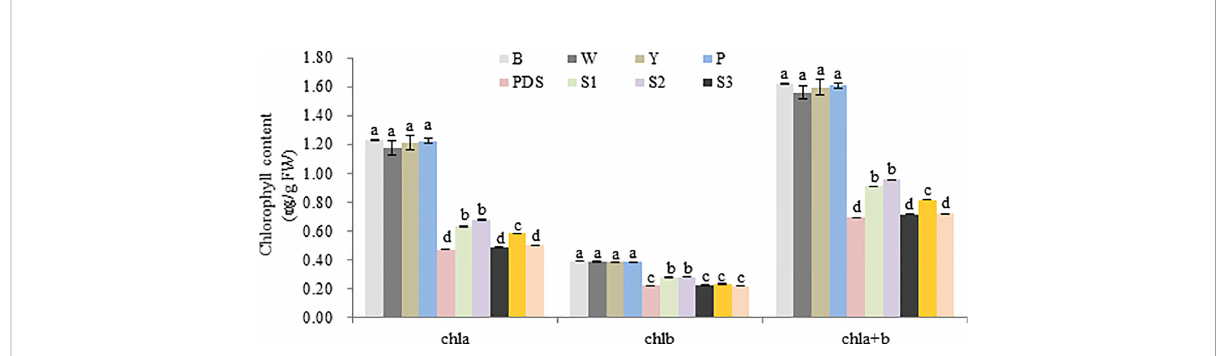
FIGURE 10 Chlorophyll content of different treatment group. B, W, Y, P, PDS, S1, S2, S3, S4,and S5 represents blank control, water control, YEP medium control, blank vector control, positive control, Cla97C02G036010 , Cla97C02G036030 , Cla97C02G036040 , Cla97C02G036050 and